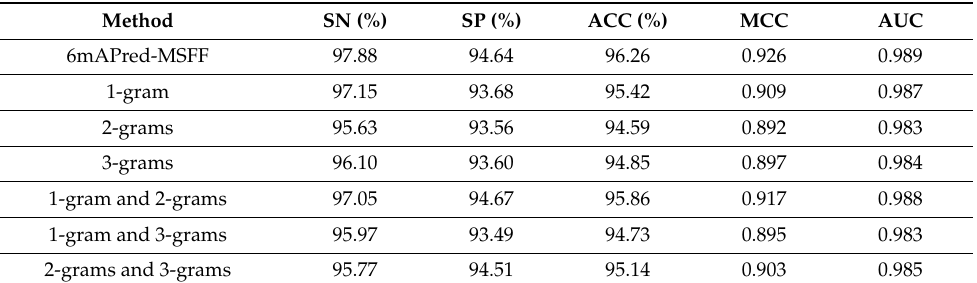
Table 4. Performance comparison of the proposed method on different encoding schemes based on the 6mA-rice-Lv dataset.